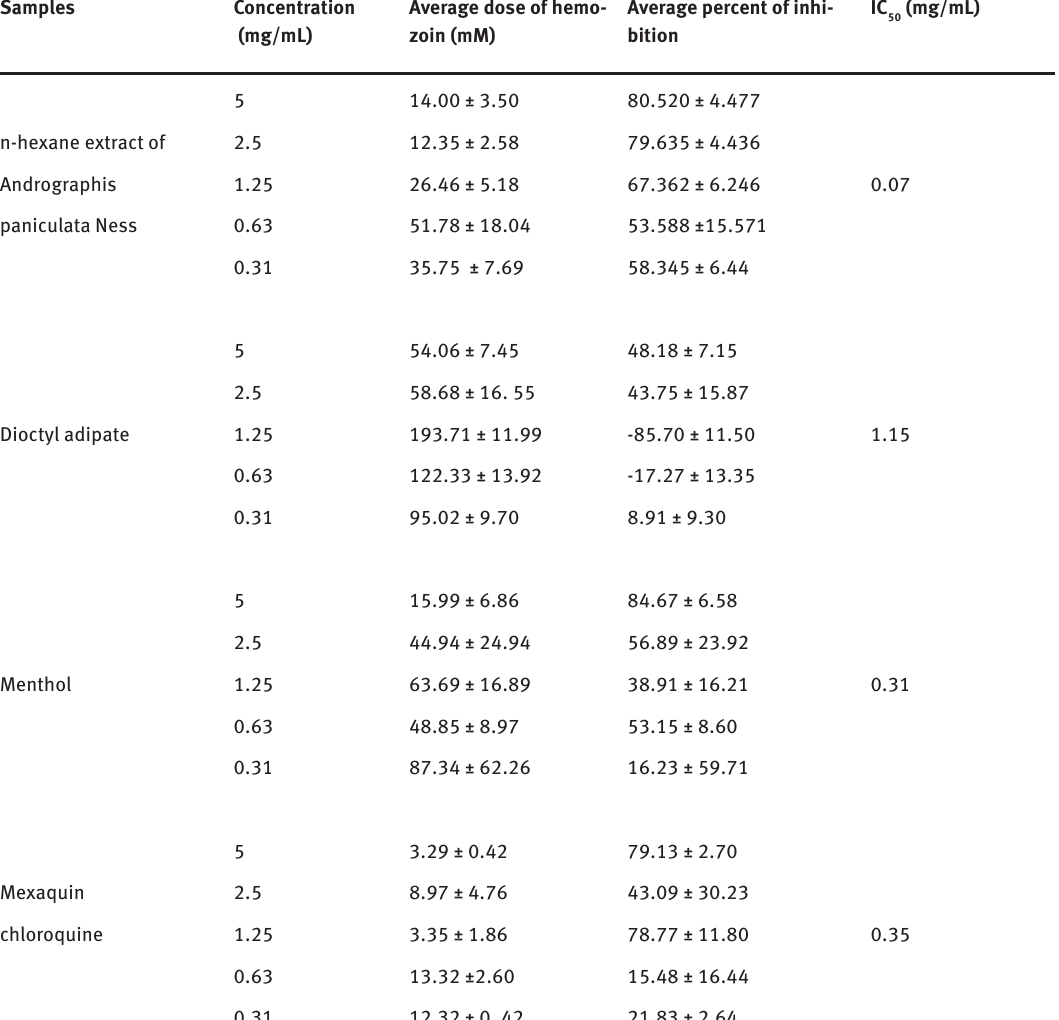
values of n-hexane extract, dioctyl adipate, menthol, negative and positive controls based on HPIA assay. Table 4: The IC 50 Samples